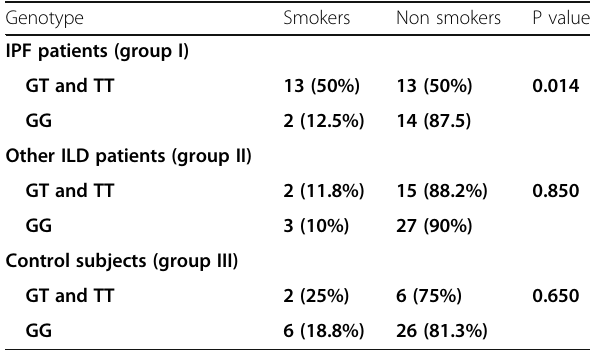
Table 4 The genotypes of MUC5B promoter polymorphism as regards the smoking status among the 3 studied groups